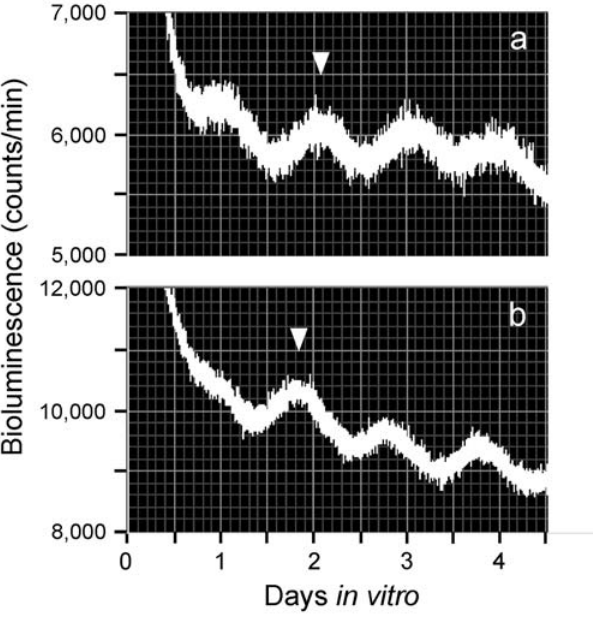
Figure 2. Rhythms of light emission by fetal SCN explants. Shown are raw data from (a) a fetus of an ad lib fed control pregnant animal and (b) a fetus of a pregnant animal that had been exposed to a 4-hour RF regimen for 21 days after mating. Because the pattern of light emission is quite variable during the first 12 to 14 hours after explantation, we consider that the phase of the tissue in vivo is best reflected by the phase of the peak during the first full subjective day (1 to 2.5 days after explant) as previously described [13]. The phase of these peaks is consistent from animal to animal (Fig. 4). Here, the phase statistically chosen is indicated by the inverted